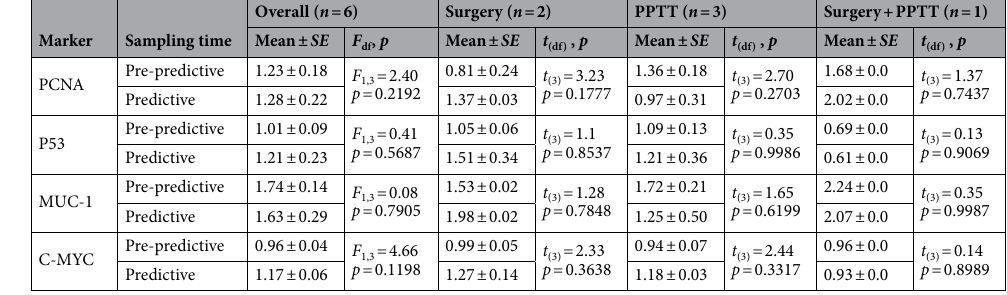
Table 6. Comparison between AAbs values measured just before the appearance of recurrent tumors (predictive), and last values measured before the predictive values (pre-predictive). The overall values were calculated regardless of treatments. Significant results at p < 0.05 if (bold).